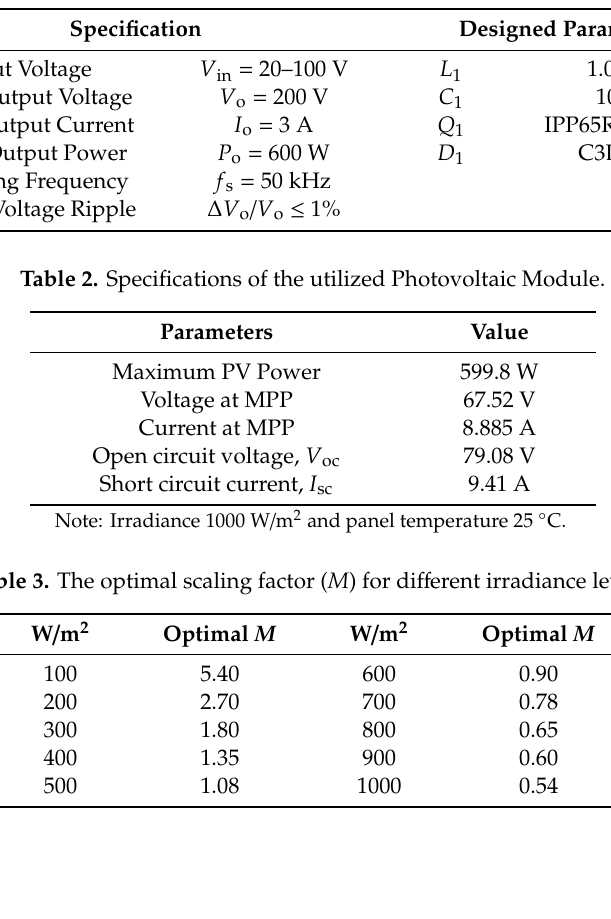
Table 1. Specification of the utilized boost converter.